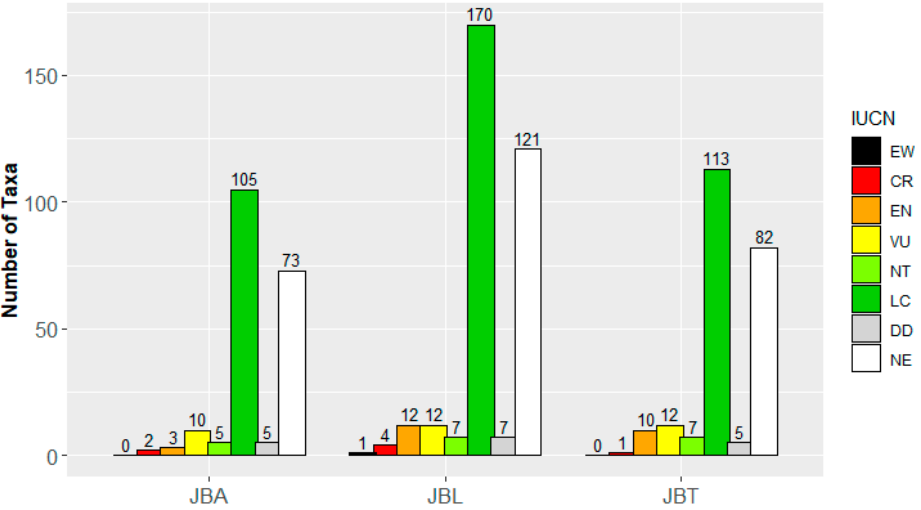
Figure 4. IUCN classification of the taxa composing the arboreal stratum of the three Botanical Gardens of Lisbon. [EW, Extinct in Wild; CR, Critically Endangered; EN, Endangered; VU, Vulnerable; NT, Near Threatened; LC, Least Concern; DD, Data Deficient; NE, Not Evaluated]. The number of species belonging to each IUCN category is shown.